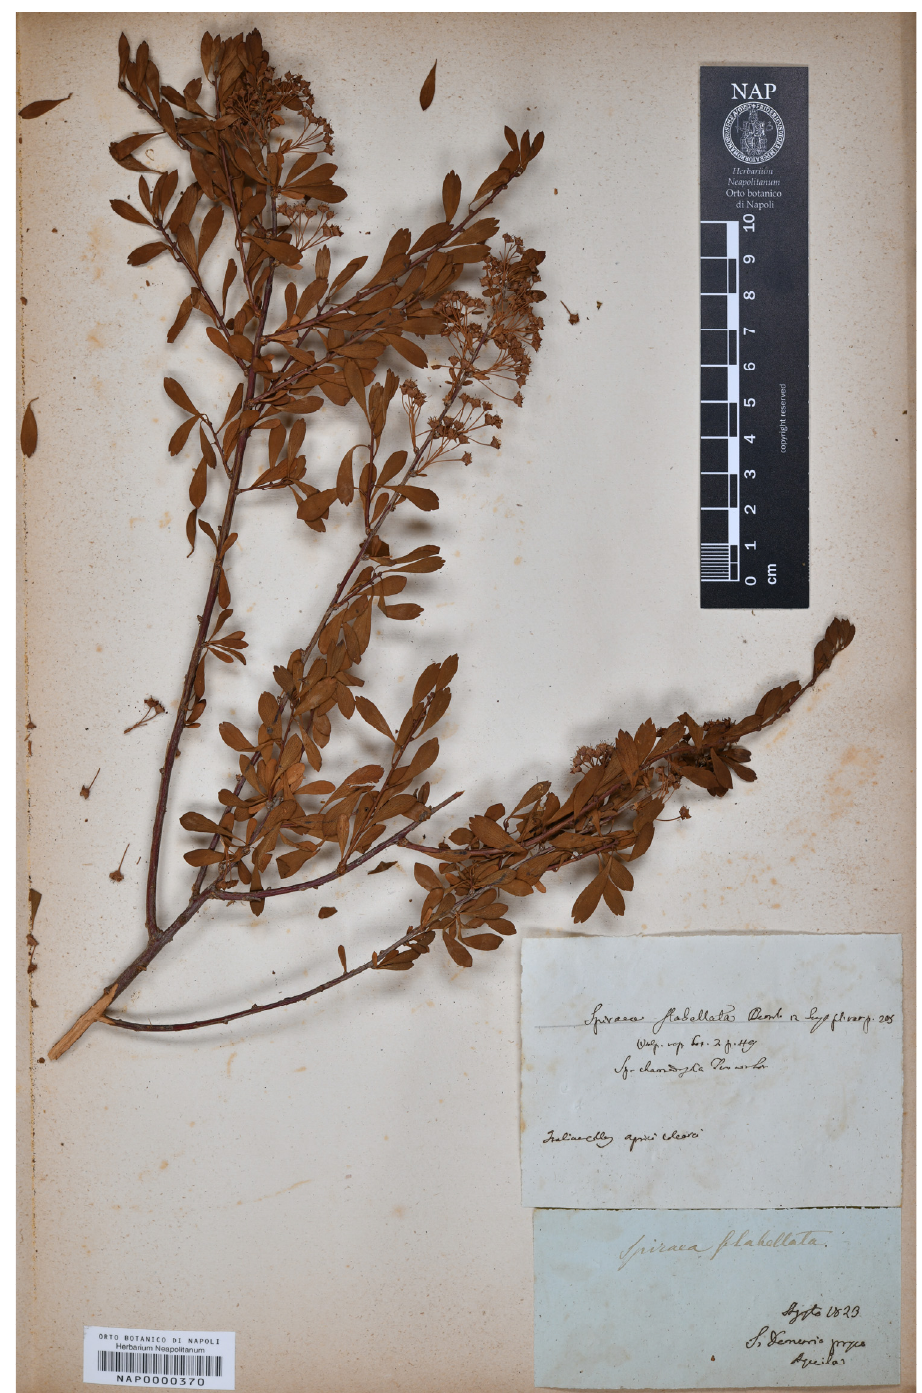
Figure 1. Lectotype of the name S. flabellata kept in NAP, barcode NAP0000370 (reproduced with permission of the Herbarium Neapolitanum , University of Naples Federico II, Italy).